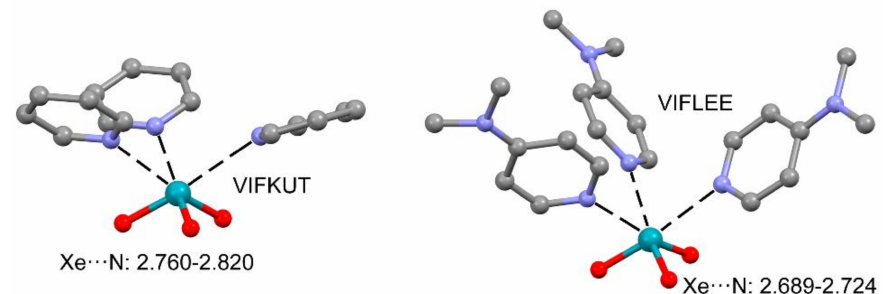
Figure 13. Partial views of the X-ray structures corresponding to CSD reference codes VIFKUT ( left ) and VIFLEE ( right ). Distances in Å. The H-atoms are omitted for